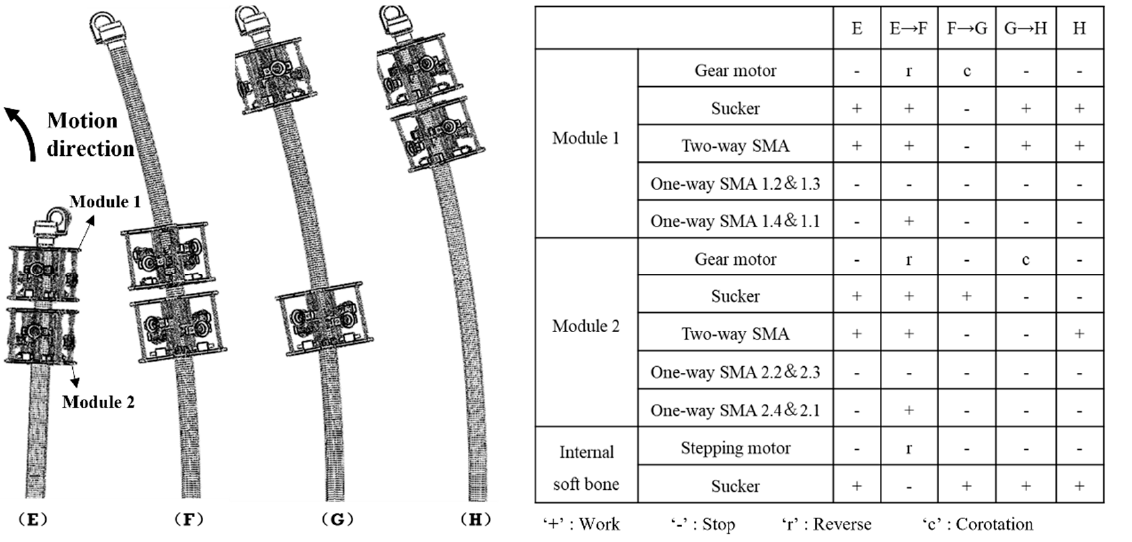
Figure 4. Steering motion planning of ISB-MWCR and the status of its corresponding components.